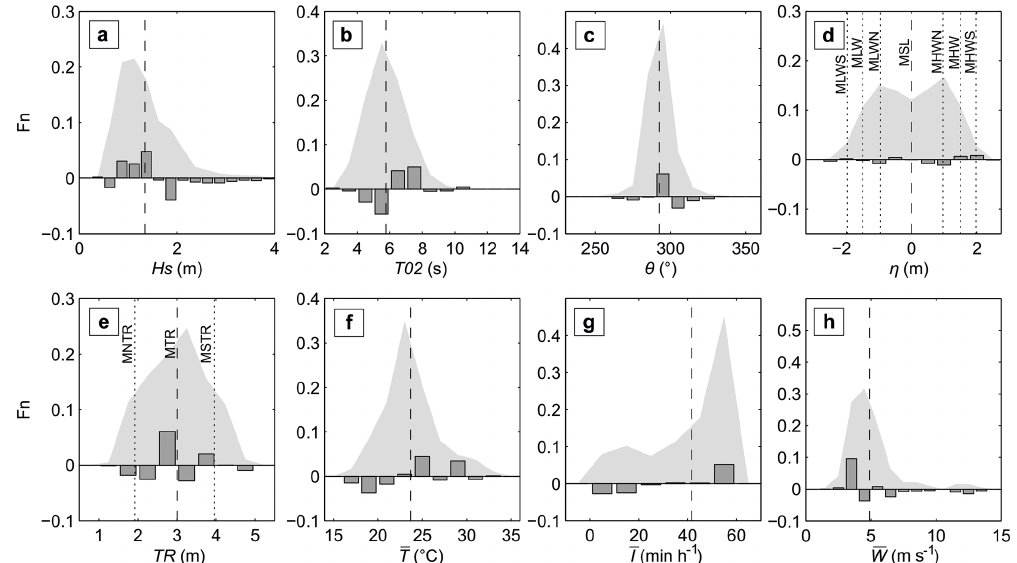
Figure 3. Environmental controls on surfing-activity-related SZIs: normalised frequency distributions Fn during the summers of 2007, 2009 and 2015 (light grey region), referred to as “average” background distribution, of (a) significant wave height, Hs ; (b) mean wave period, T 02; (c) wave direction, θ ; (d) water level, η ; (e) daily tide range, TR; (f) daily mean air temperature, T ; (g) daily mean hourly insolation, I ; and (h) daily mean wind speed, W . The dark grey bars show the difference between surfing-related and average background distributions and the vertical dashed lines indicate background